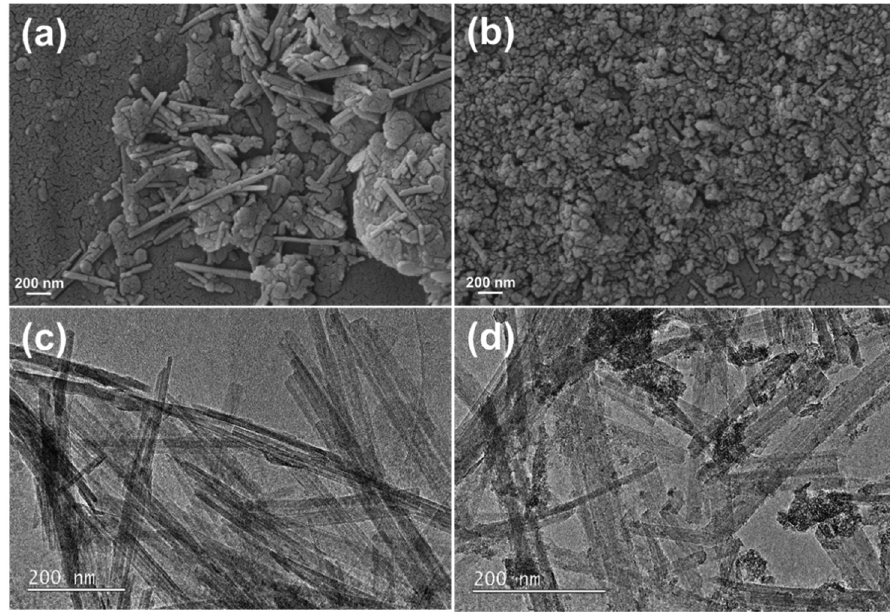
Figure 2: The SEM images of ( a ) ATP and ( b ) Zr@ATP; and the TEM images of ( c ) ATP and ( d )